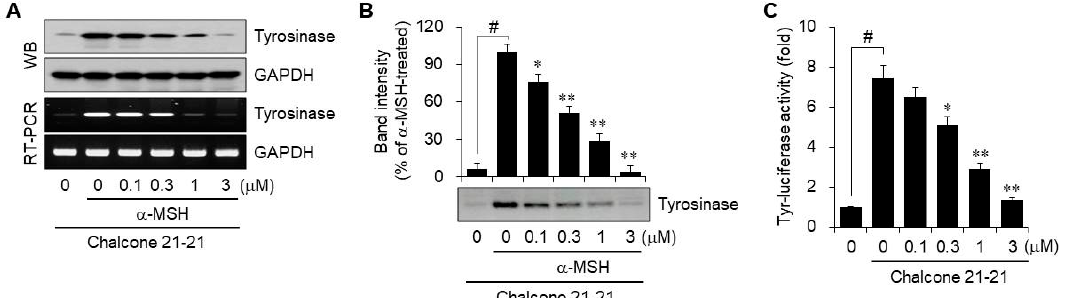
Figure 3. Chalcone 21-21 inhibits tyrosinase activity. ( A ) B16F10 cells were incubated for 72 h with vehicle (0.1% DMSO) alone or various concentrations of chalcone 21-21 in the absence or presence of α -MSH (10 nM). The level of tyrosinase was determined by Western blot or RT-PCR analyses. GAPDH served as a loading control. ( B ) Total cell lysates were prepared as mentioned above in Figure 3A. Tyrosinase activity was determined by zymography, and the band densities are represented. ( C ) B16F10 cells were transiently transfected with a reporter construct of tyrosinase together with the pRL-TK. The cells were incubated for 24 h with vehicle (0.1% DMSO) alone or with various concentrations of chalcone 21-21 in the absence or presence of α -MSH (10 nM). Luciferase activity was measured and firefly luciferase activities were normalized to that of Renilla luciferase. Results are represented as mean ± SD from three independent experiments ( n = 3). p -values of # p < 0.005 compared to the vehicle-treated group and * p < 0.05 and ** p < 0.005 compared to the α -MSH-treated group were considered statistically significant.